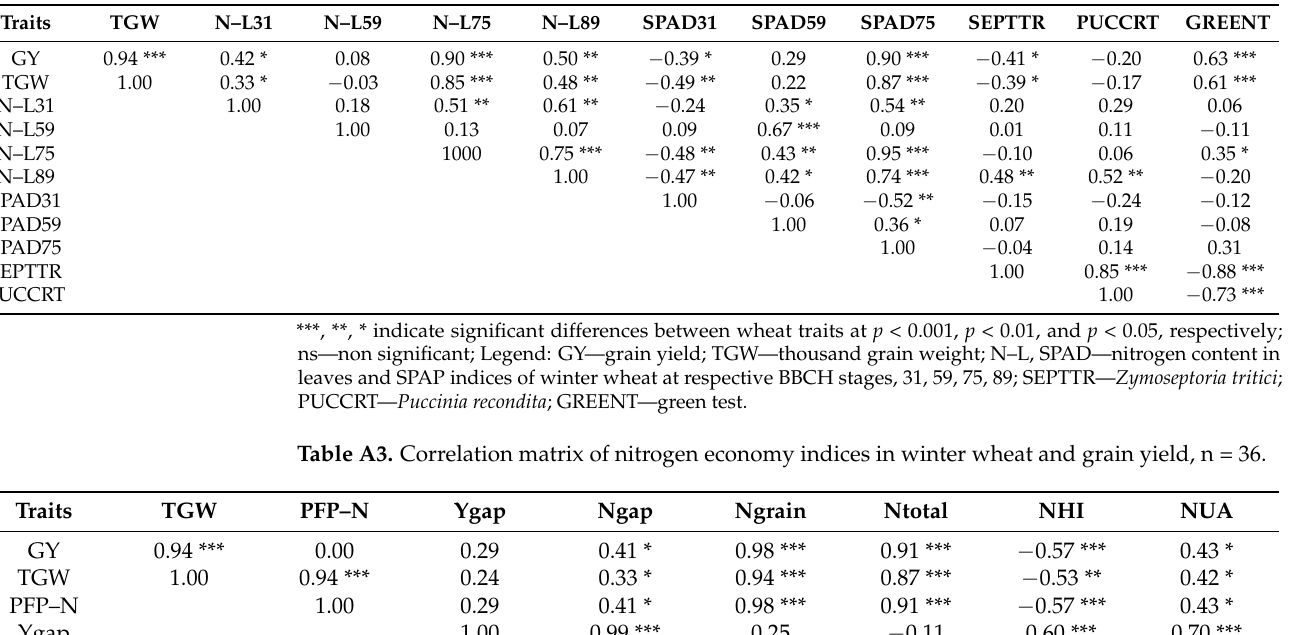
Table A2. Correlation matrix of the content of N, SPAD, and winter wheat infestation with pathogens, n = 36.